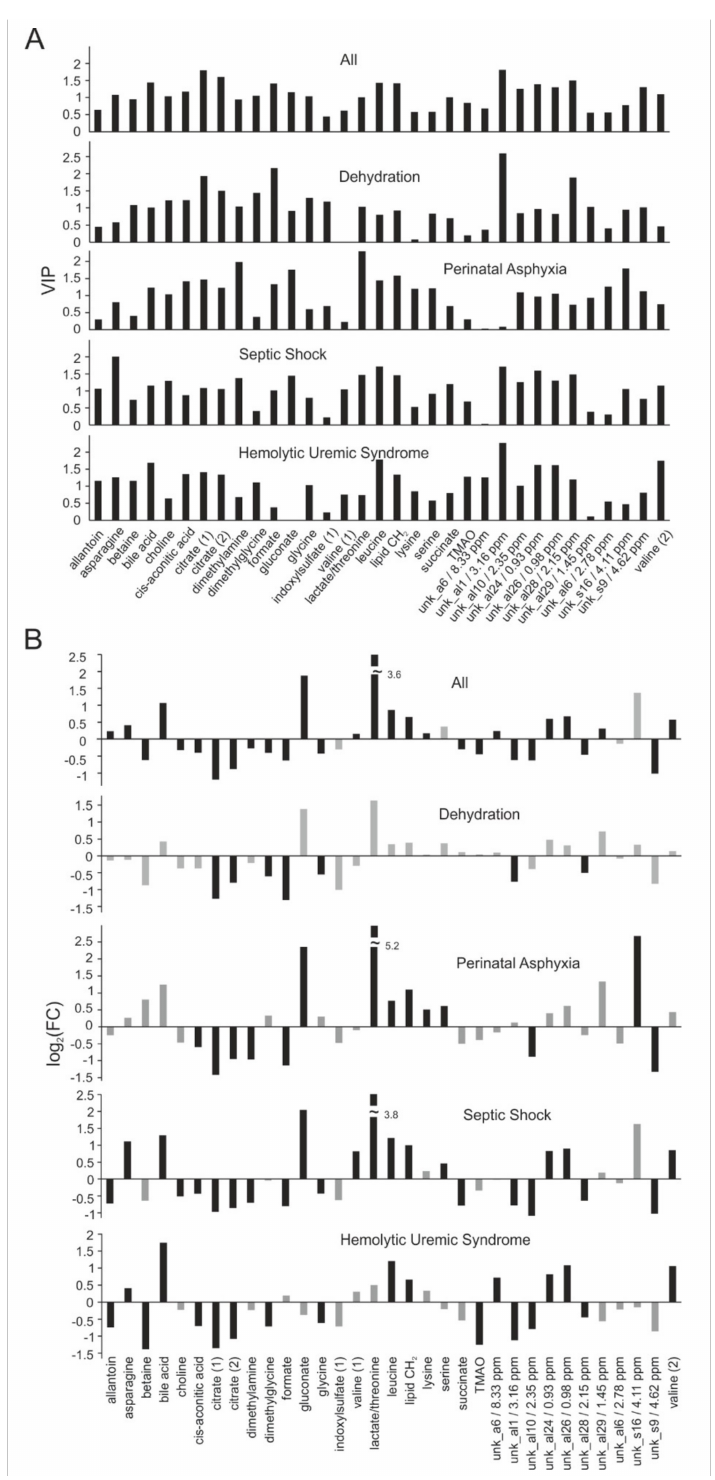
Figure 4. ( A ) Overview of discriminant identified metabolites according to variable importance in projection (VIP) values analyzed separately for each etiology. VIP values were obtained from a PLS-DA analysis. Only metabolite buckets are shown that had VIP values > 1.1 for at least one of the di ff erent groups. ( B ) The respective fold changes (log 2 (FC)) for the same metabolites are given for comparison. Black bars denote fold changes with an associated p -value < 0.01, grey bars those with a p -value > 0.01. PLS-DA, partial least squares discriminant